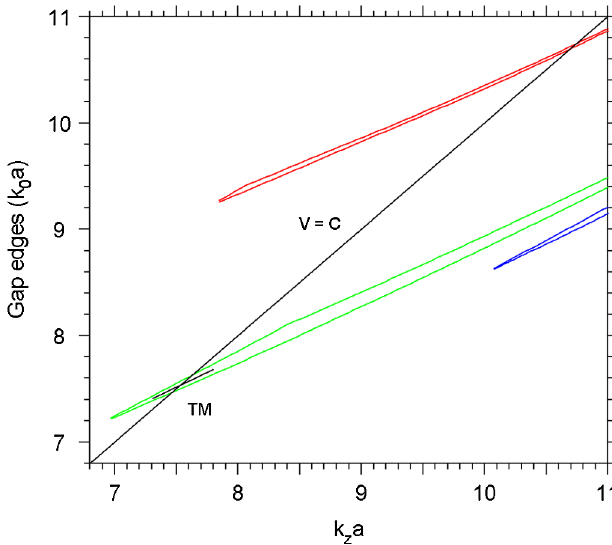
FIG. 16. Band gap diagram calculated with BANDSOLVE of a high-impedance TM mode fiber, showing the location of the SOL mode for the matrix parameters r=a ¼ 0 : 31 and R=a ¼ 0 : 478